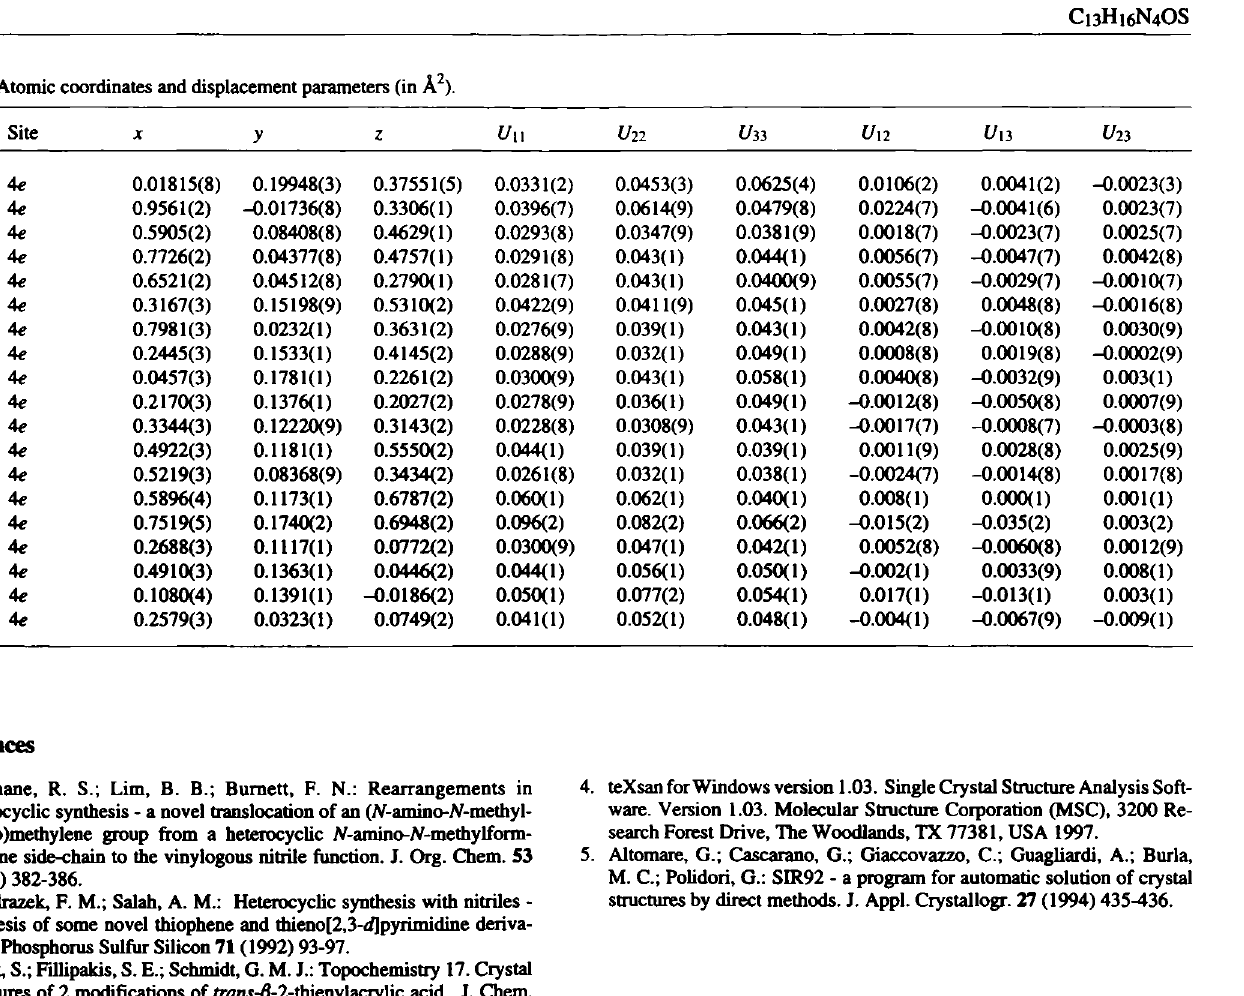
Table 3. Atomic coordinates and displacement parameters (in Â 2